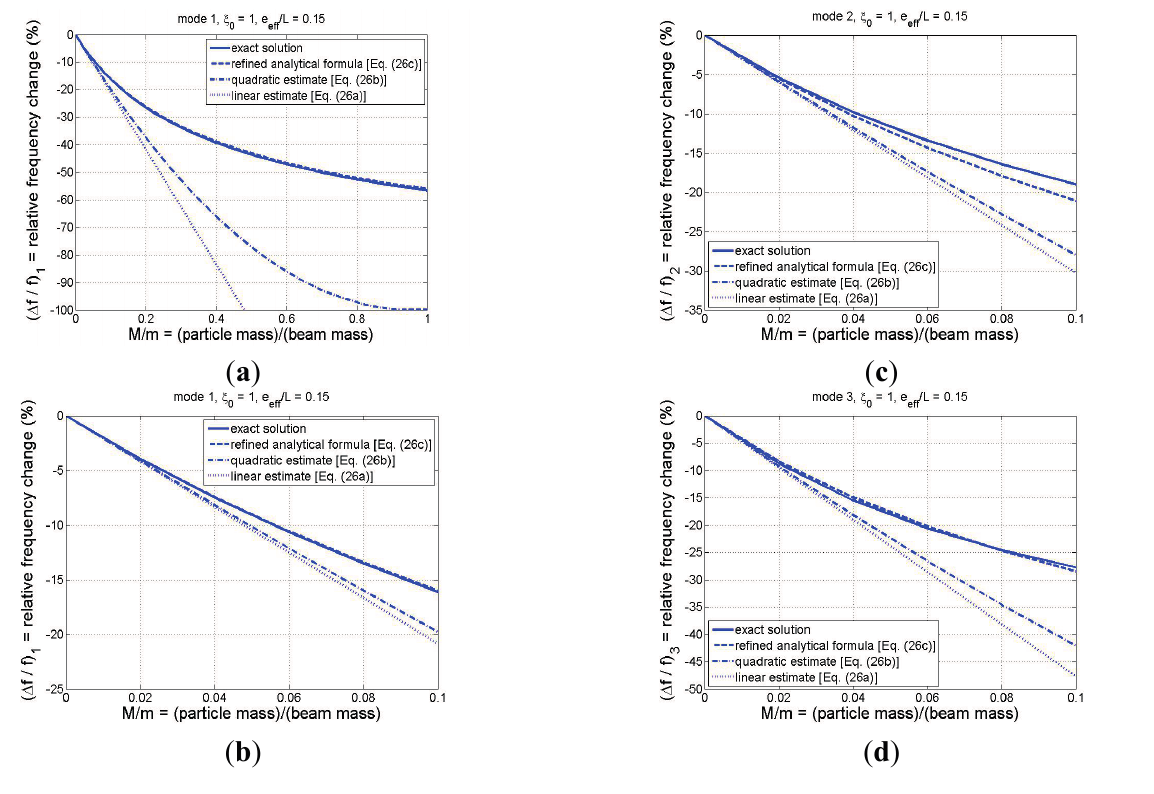
Figure 3. Comparison of relative frequency shifts predicted by the exact model and the various analytical formulas for mode 1 for